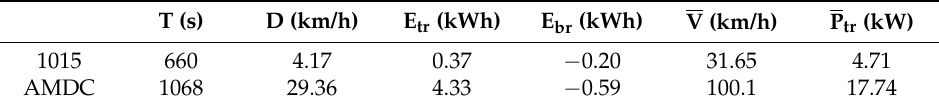
Table 7. Main specifications of the two driving